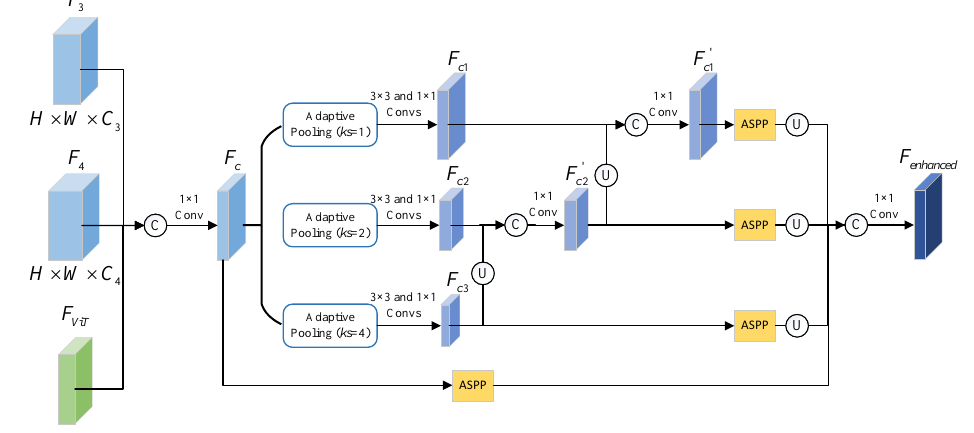
Figure 3. The visual illustration of the MCE module, which receives two ResNet-50 features and one ViT feature, and then uses multi-scale pooling operations with different pooling rates and four parallel ASPP modules to generate enhanced